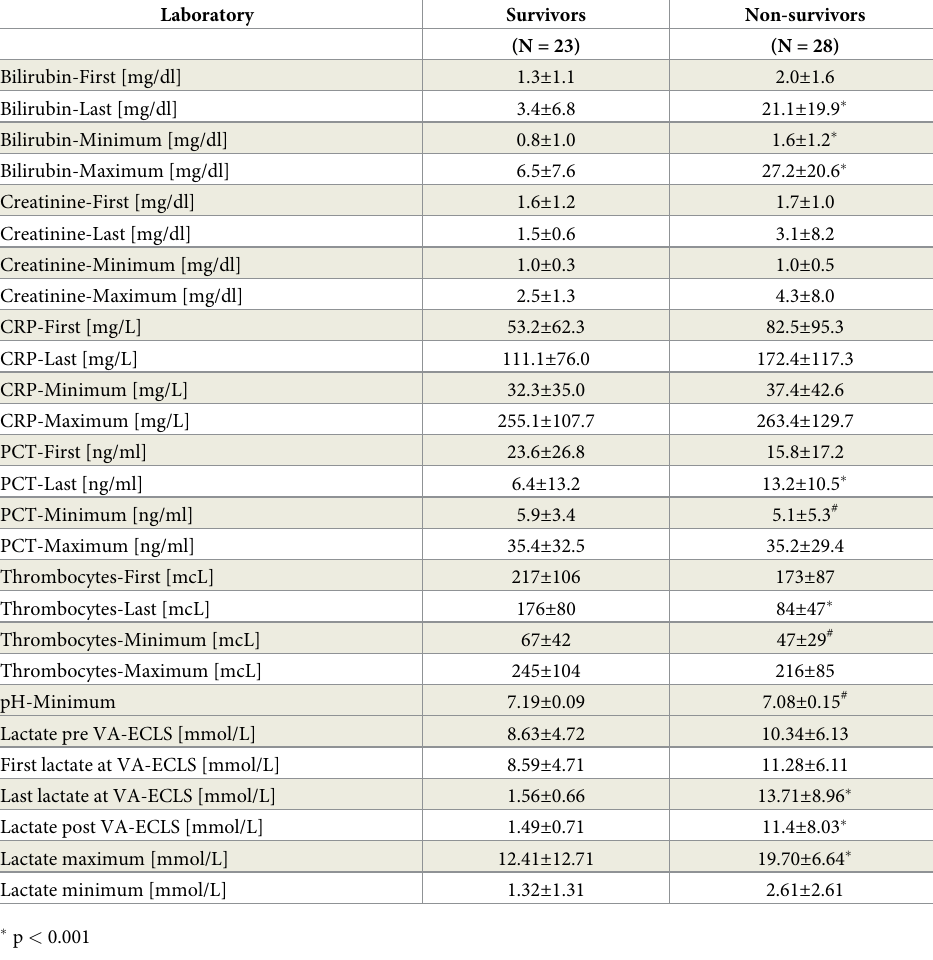
Table 3. Laboratory